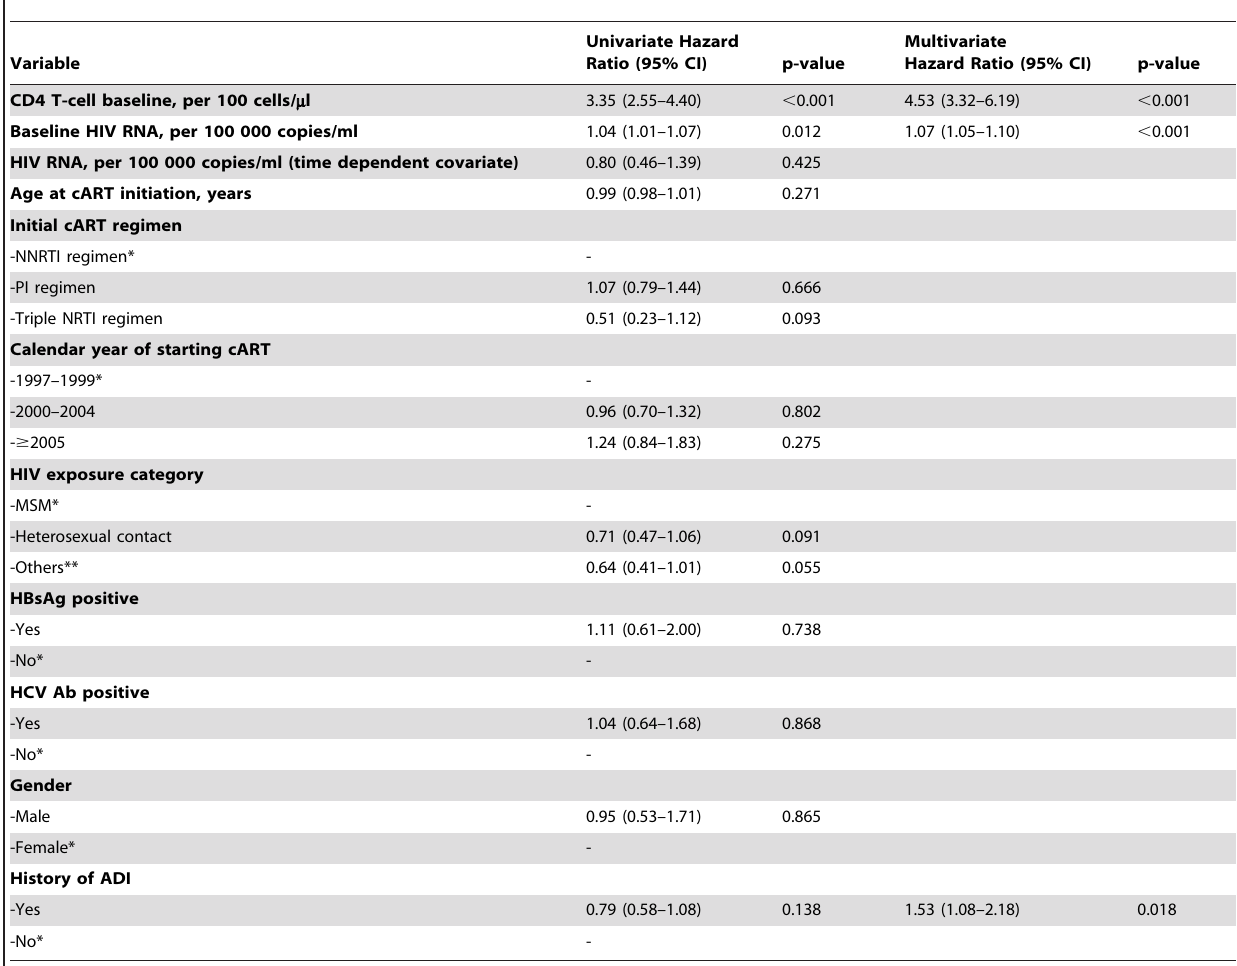
Table 3. Predictors of time taken to achieve CD4 T-cells . 200 cells/ m l (n